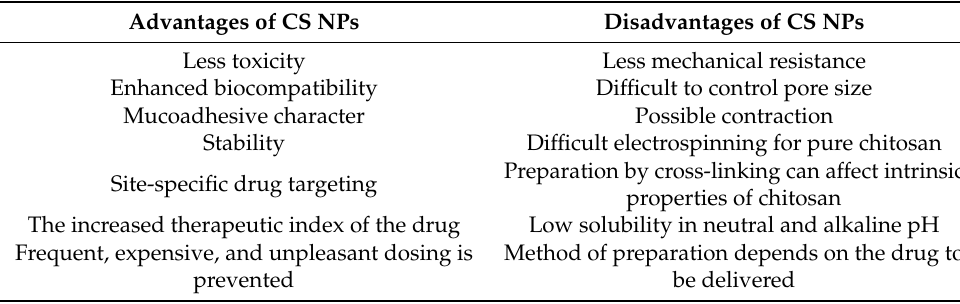
Table 2. Advantages and limitations of CS NPs